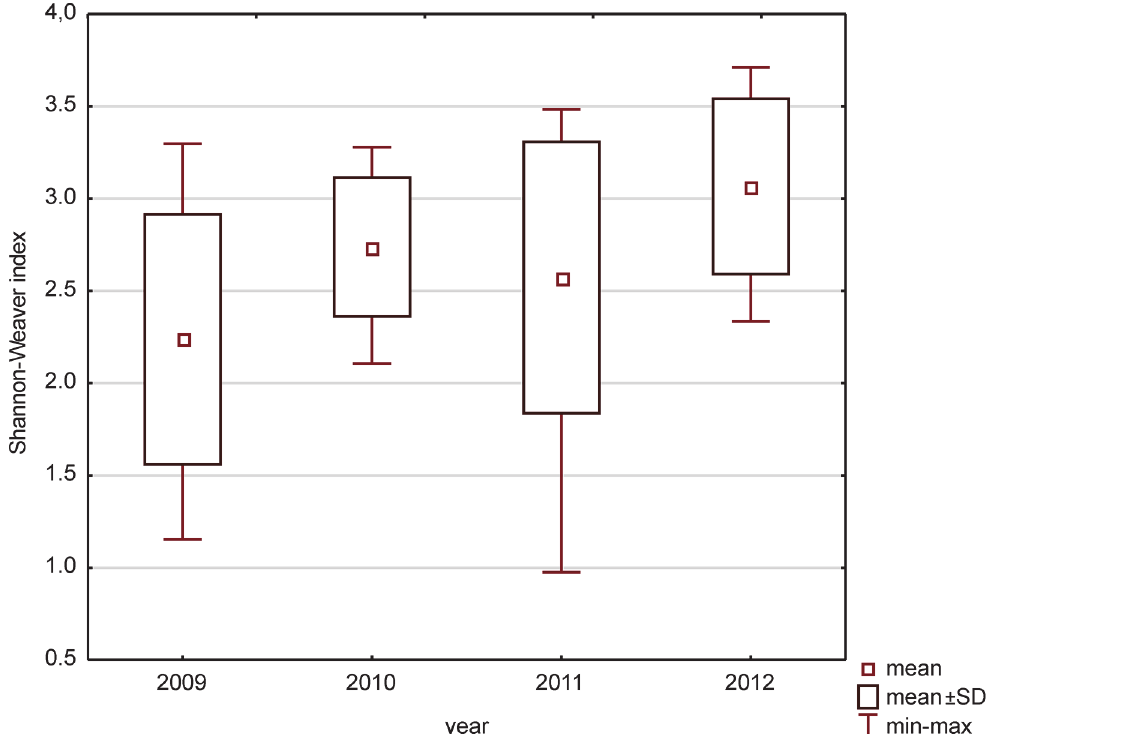
Fig 4. The mean, maximum and minimum values of Shannon-Weaver index in each year in Malta ń ski Reservoir.